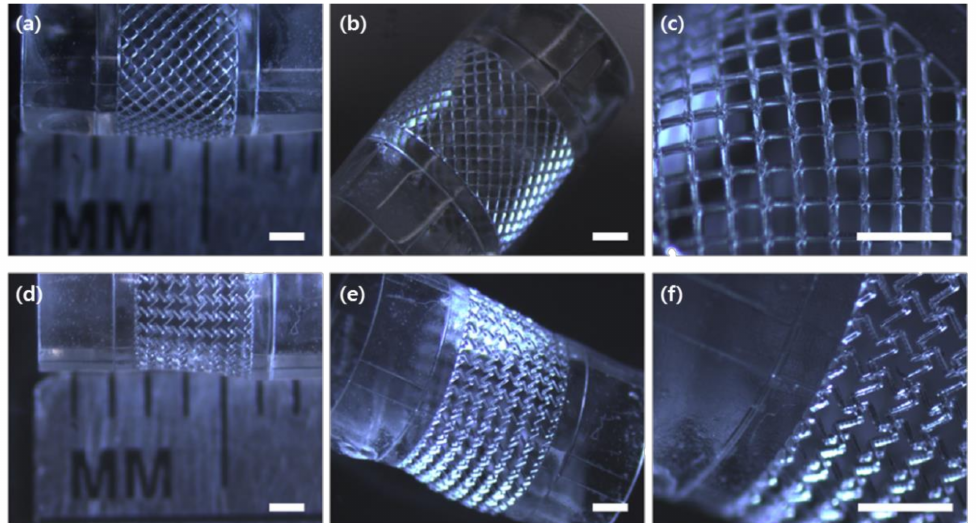
Figure 6. Fabrication results of tubular structures with unit cells. ( a – c ) Non-auxetic structure with intact ribs. ( d – f ) Auextic (NPR) structure with cut-missing ribs (scale: 1 mm)